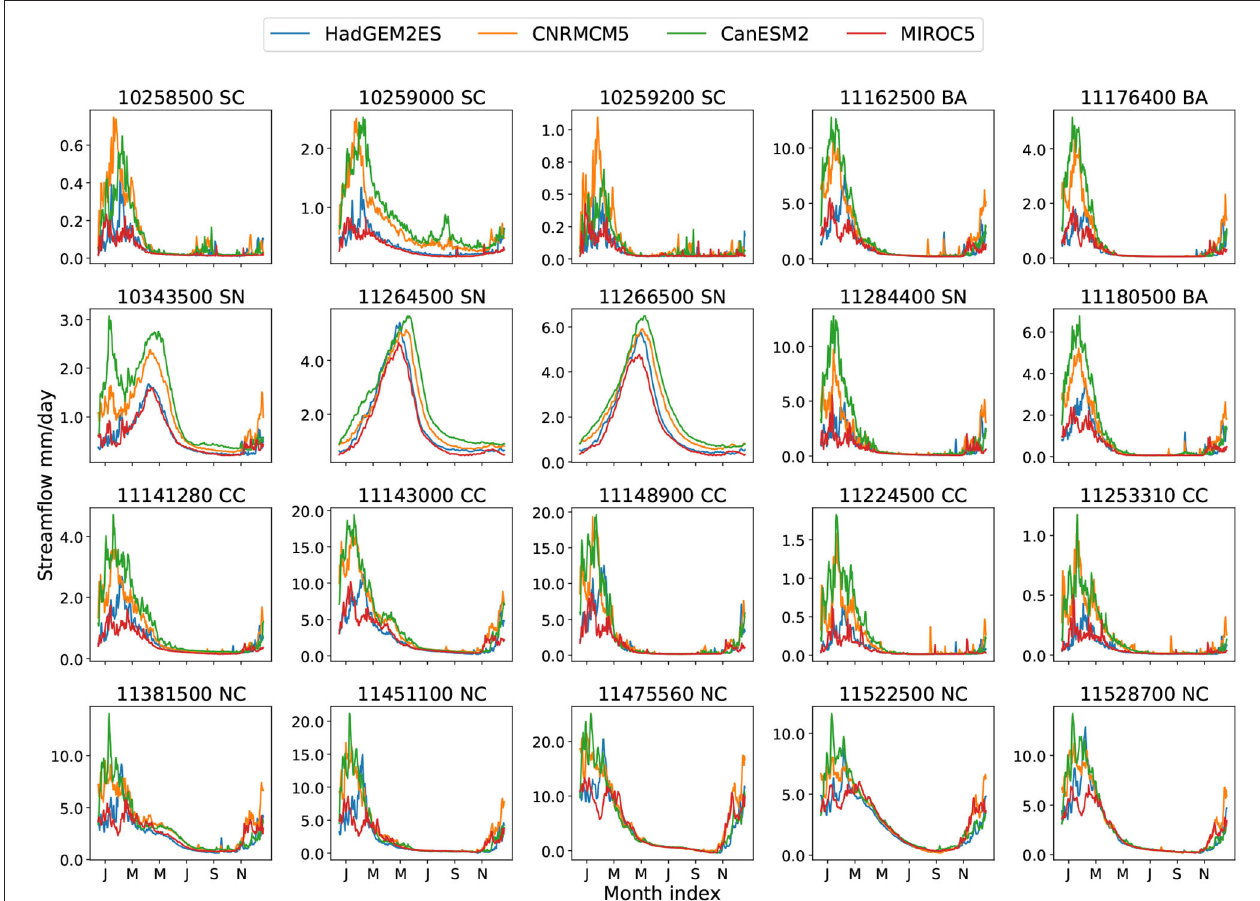
FIGURE 7 | Projection climatological daily streamflow from four climate